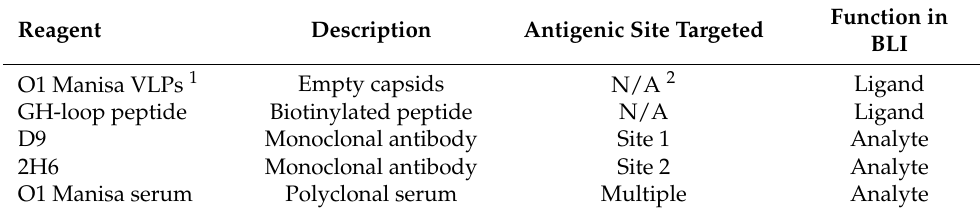
Table 1. Reagents and their role during bio-layer interferometry